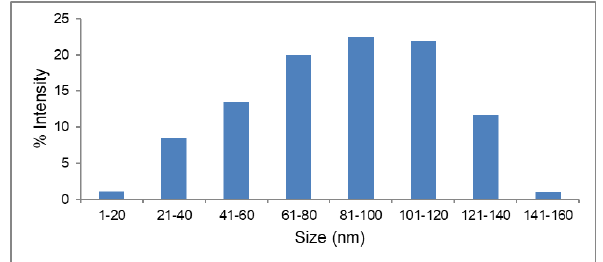
Fig. 9. Intensity Size Distribution of CuO